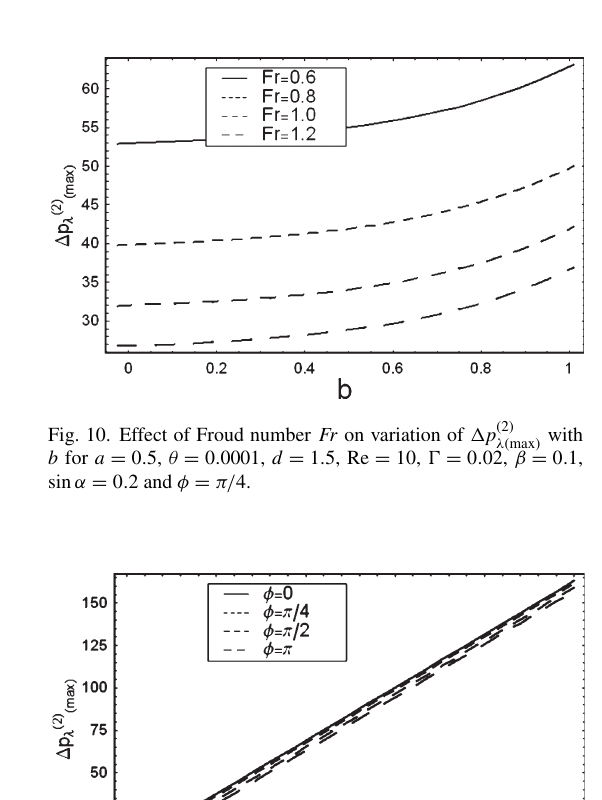
Fig.6. Effectofphasedifference φ onvariationof (cid:16)p (2) a = 0 . 7, b = 1 . 2, d = 2, Re = 10, (cid:15) = 0 . 01, β = 0 . 1, sin α = 0 . 6 and Fr = 1.